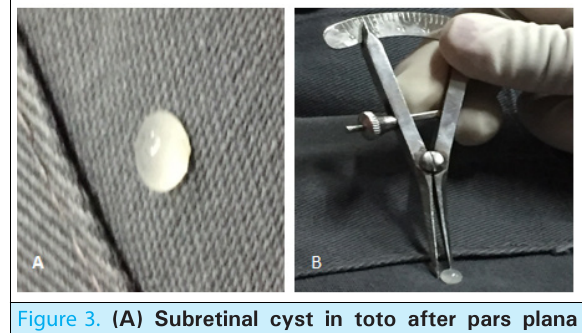
Figure 3. (A) Subretinal cyst in toto after pars plana vitrectomy with dense white scolex like material within it. (B) Cyst about 5mm in size measured by callipers.